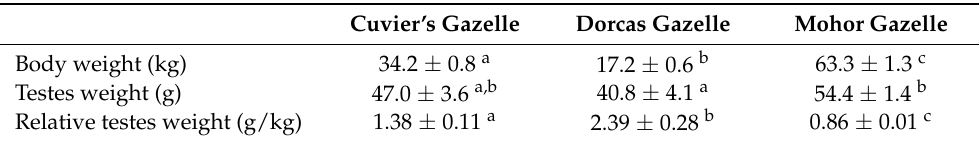
Table 1. Body, testes and relative testes weights in three species of gazelles.